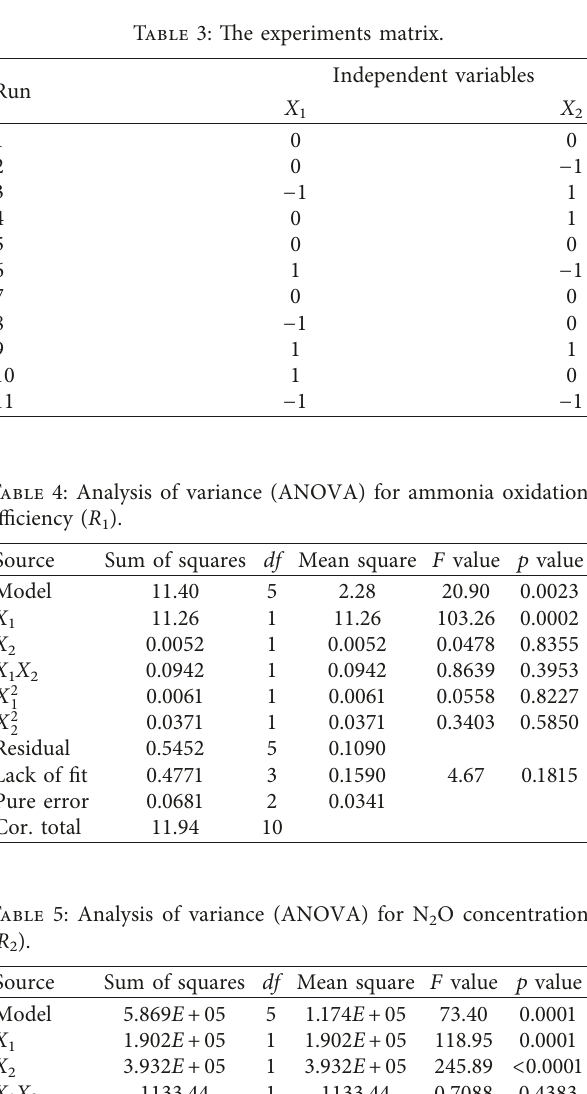
Table 3: The experiments matrix.